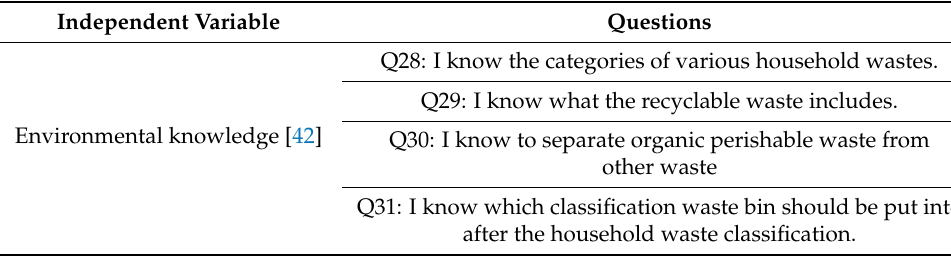
Table 7. Environmental knowledge questions.